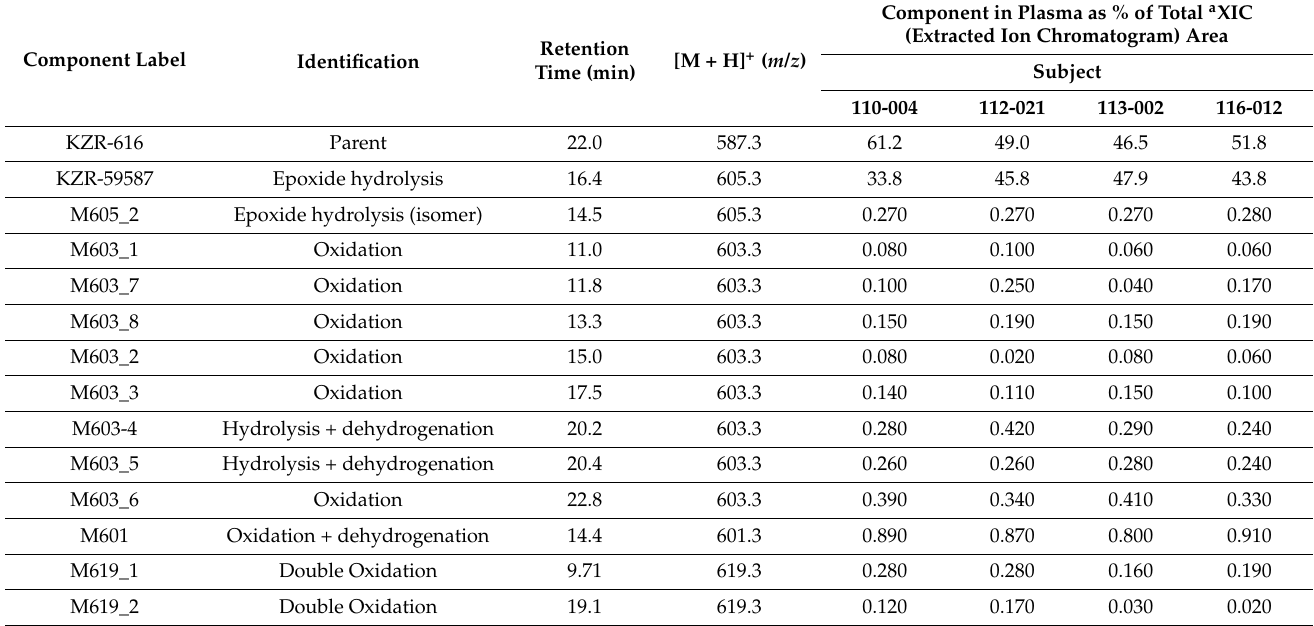
Table 2. Summary of KZR-616 and proposed metabolites observed in human plasma.